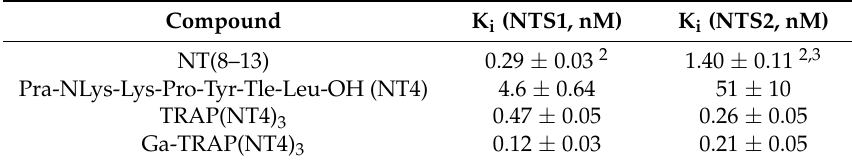
Table 1. In vitro binding affinities of Ga-TRAP(NT4) 3 to the human NTS1 and NTS2 1 .